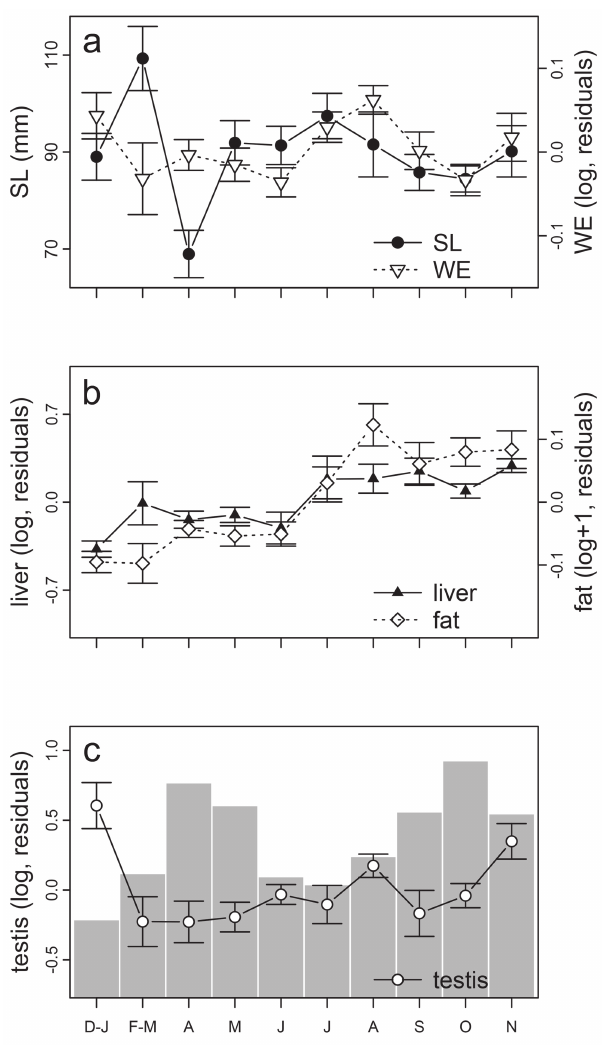
Fig. 5. Monthly variation in adult males: (a) SL, standard length and WE, eviscerated weight, (b) liver and fat weight, and (c) testis weight. Barplot behind the lines represents the rainfall